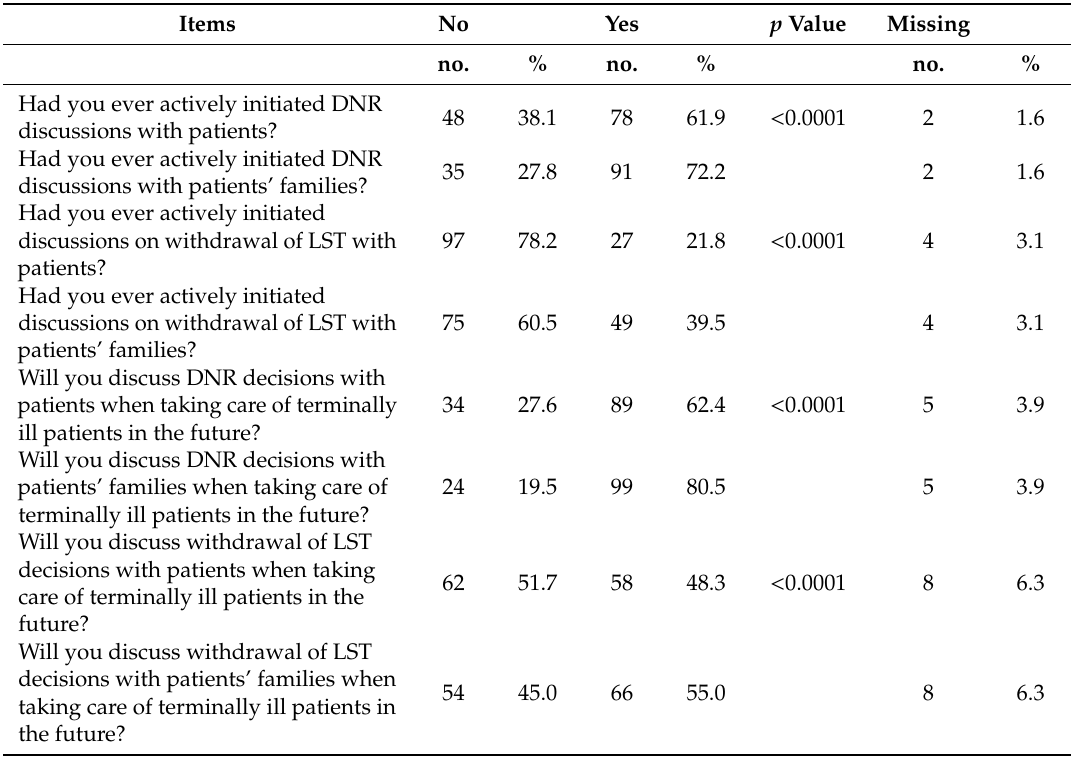
Table 2. Experiences and attitudes regarding do-not-resuscitate (DNR) and life-sustaining treatment (LST) withdrawal